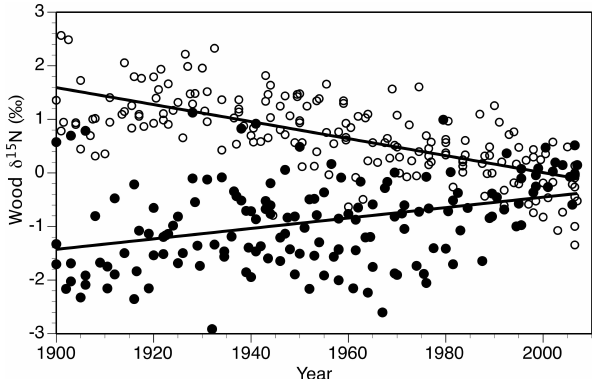
Fig. 2. Wood δ 15 N over time standardized to the same mean (0‰) across sites for Quercus alba (solid circles) and three other hard- wood species ( Carya ovata , Fagus grandifolia , and Acer saccha- rum , open circles). Lines represent linear regression between mean year of wood formation for each segment and wood δ 15 N values for Quercus alba ( r 2 = 0 . 11, P < 0 . 001) and other species ( r 2 = 0 . 46, P < 0 .